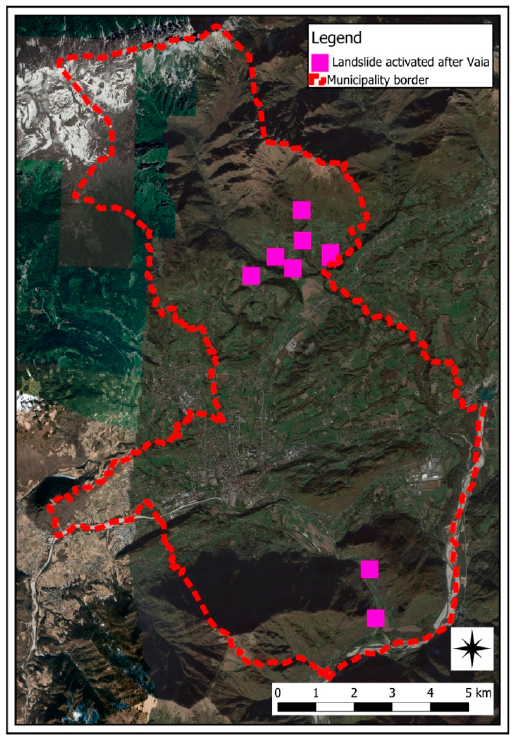
Figure 14. True ‐ colour satellite image (Bands 4, 3, 2) from the Sentinel ‐ 2 satellite, showing the lo ‐ Figure 14. True-colour satellite image (Bands 4, 3, 2) from the Sentinel-2 satellite, showing the location cation of the 9 landslides triggered during storm Vaia, shown in fuchsia. of the 9 landslides triggered during storm Vaia, shown in fuchsia.